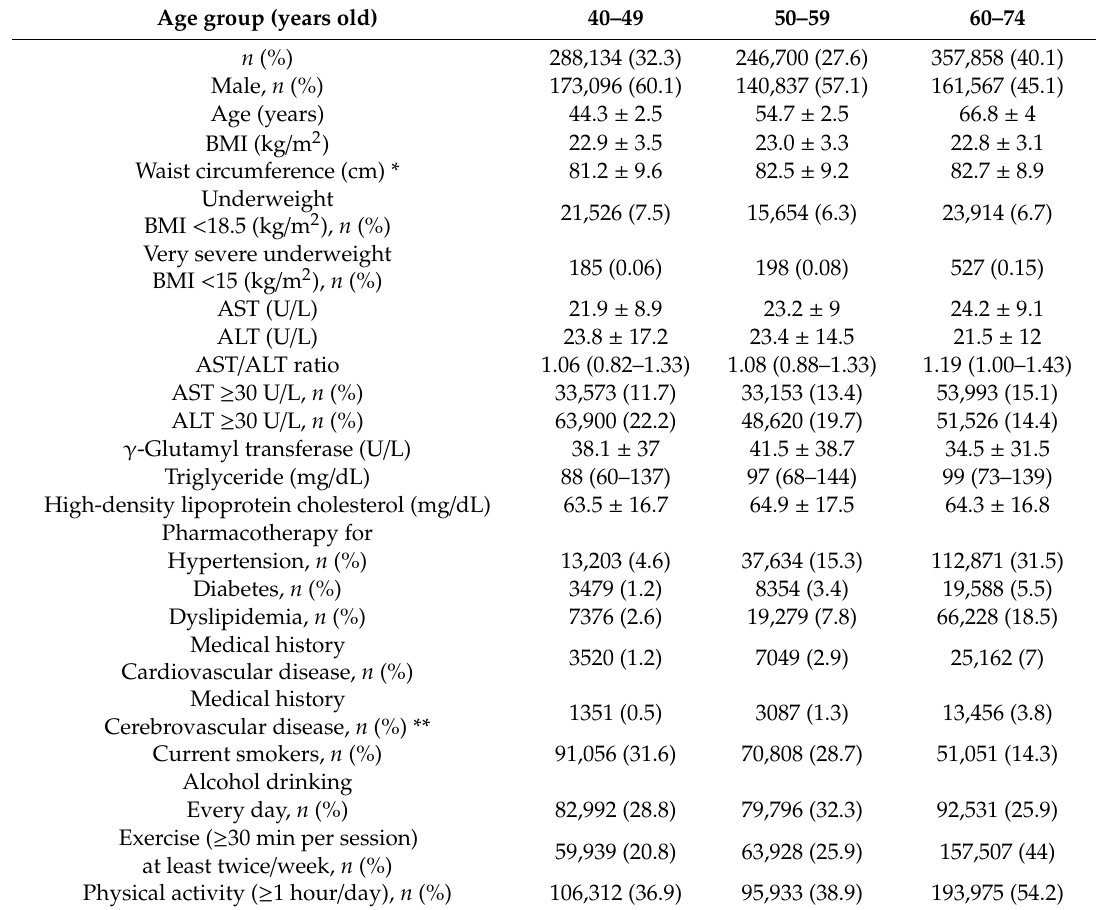
Table 1. Subjects’ characteristics classified according to